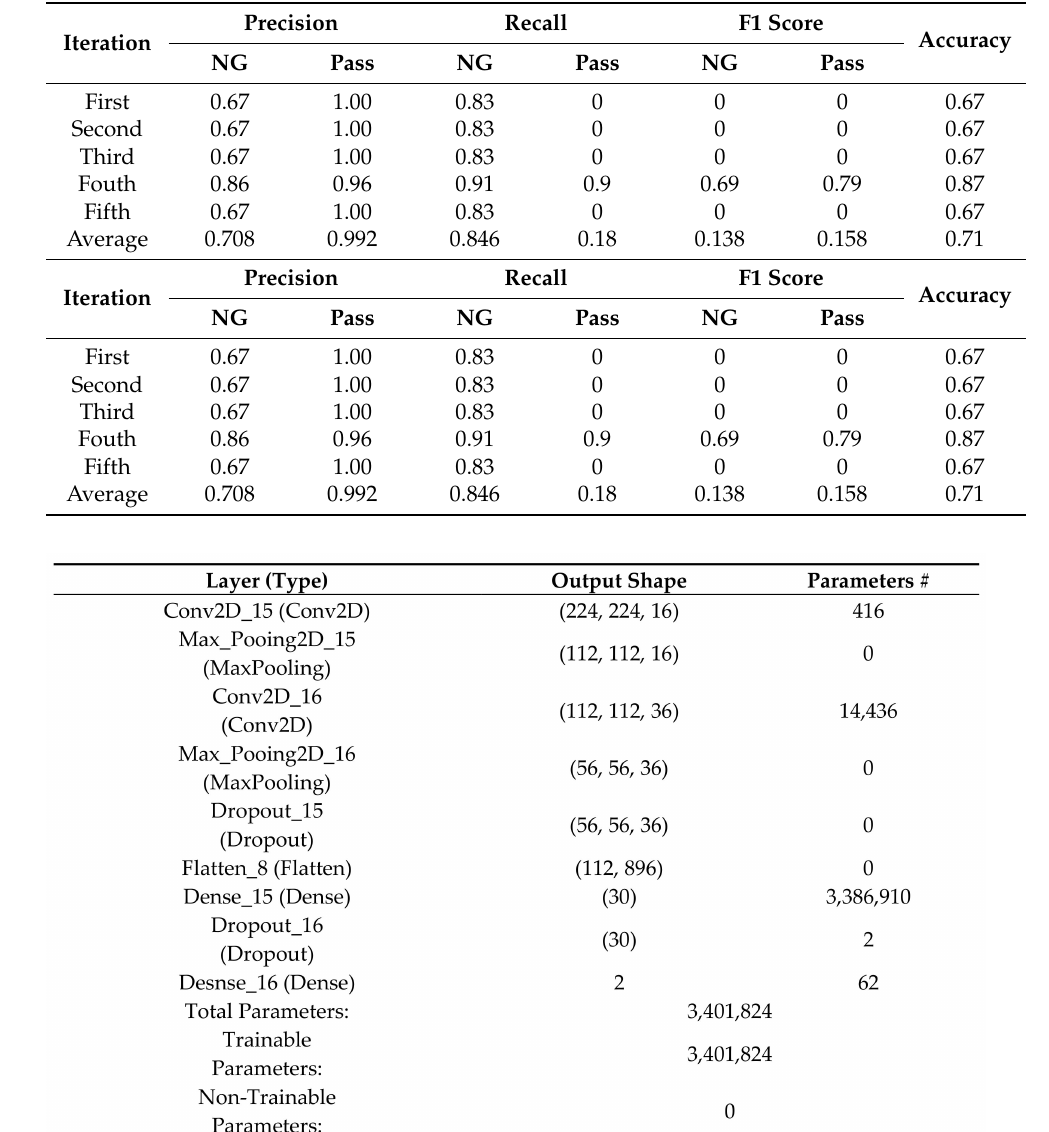
Table A4. LeNet with K-fold Iterations.